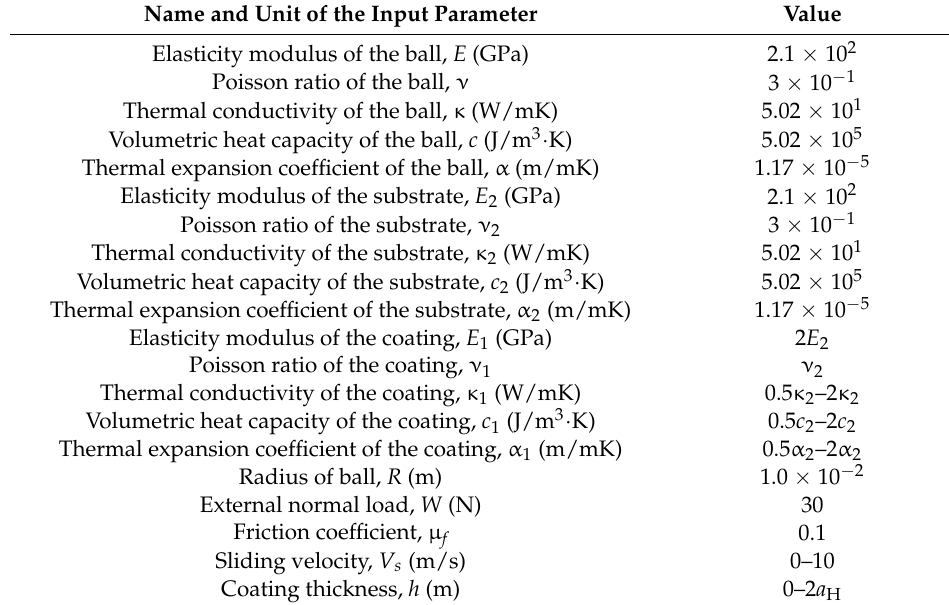
Thermoelastic properties of the coated solid and the elastic ball and the other concerning